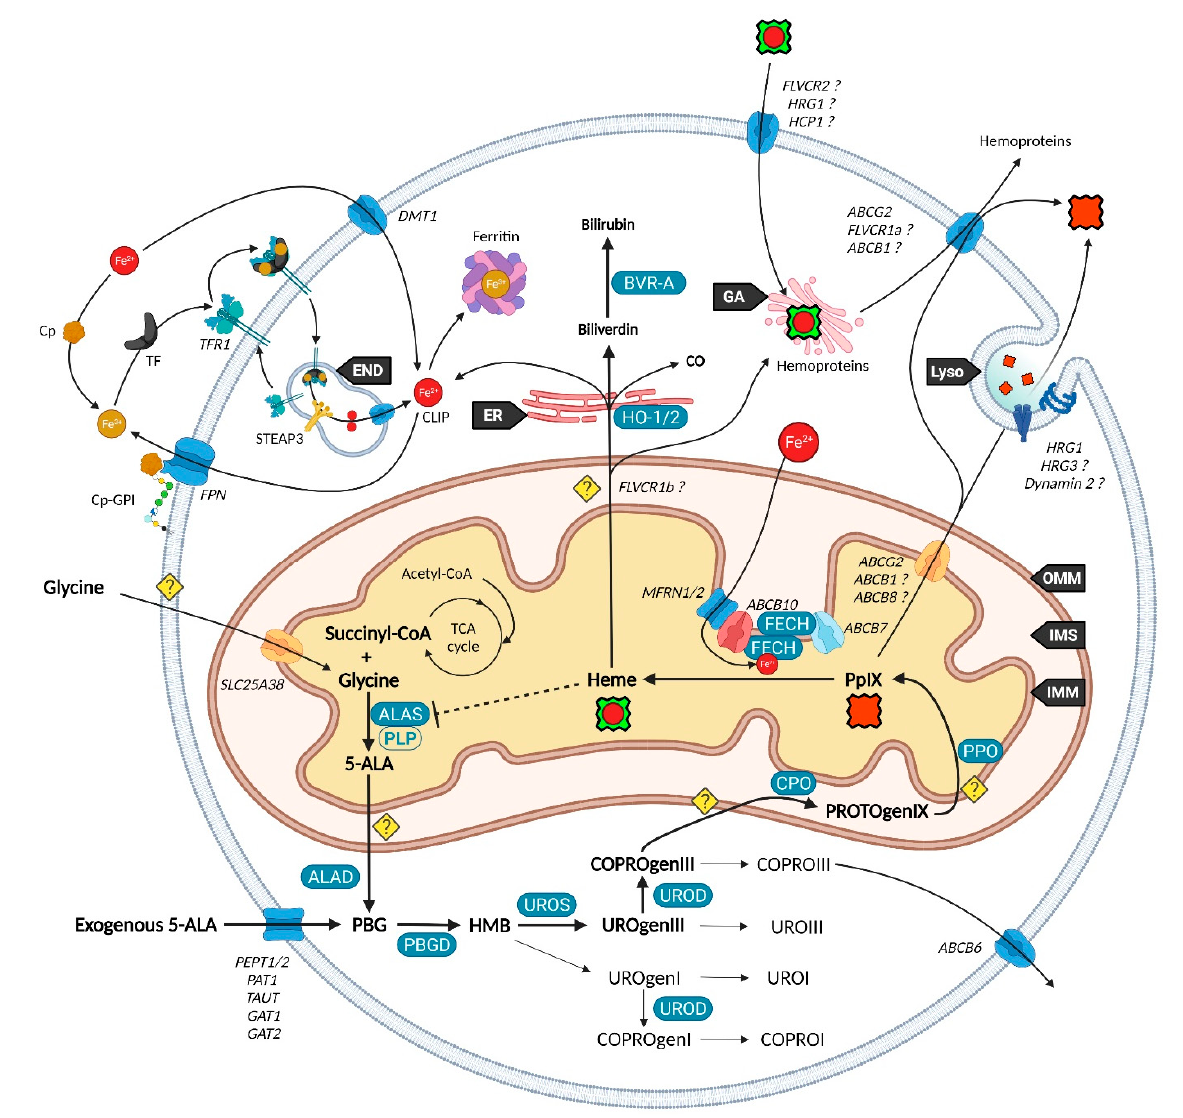
Figure 1. Current vision of the major players of heme metabolism and their interactions. Endoplas- mic Reticulum (ER), Golgi Apparatus (GA), Outer/Inner Mitochondrial Membrane (OMM/IMM), Inner Mitochondrial Space (IMS), Endosome (END), and Lysosome (Lyso). Porphobilinogen (PBG), Hydroxymethylbilane (HMB), Uroporphyrinogen (UROgen), Coproporphyrinogen (COPROgen), and Protoporphyrinogen (PROTOgenIX). For other acronyms, please refer to the table at the end.